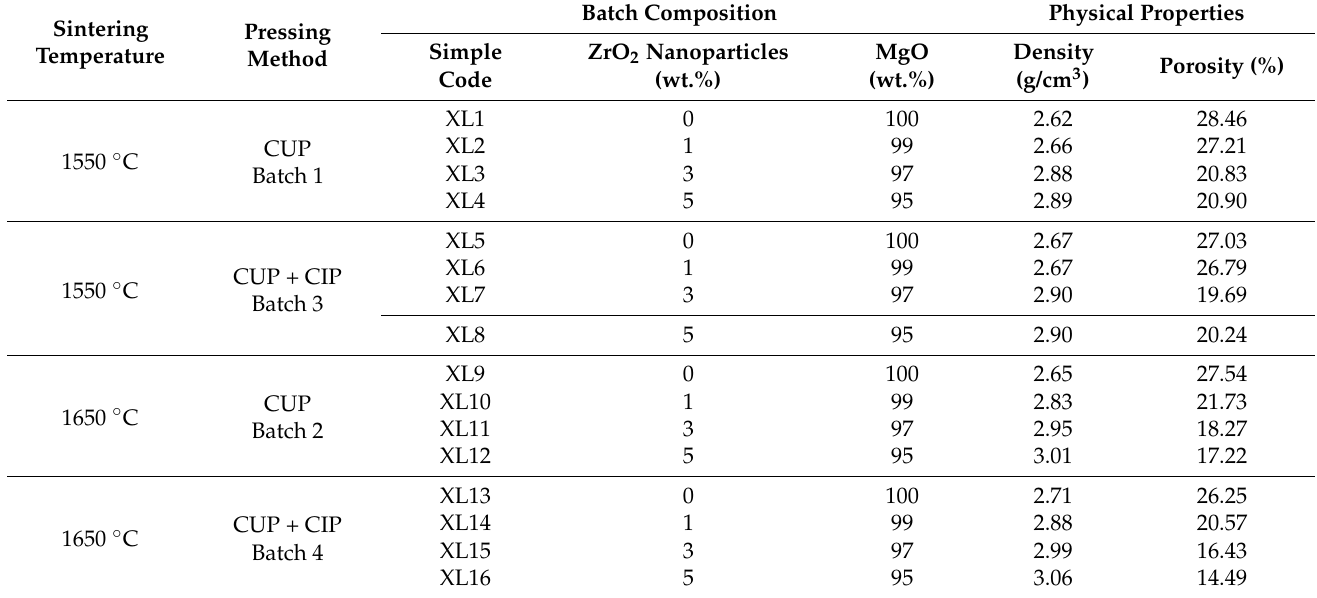
Table 1. Sintering temperature, pressing method (cold uniaxial pressing (CUP) or cold uniaxial pressing (CUP) + Cold Isostatic Pressing (CIP)), batch composition and physical properties of sam- ples